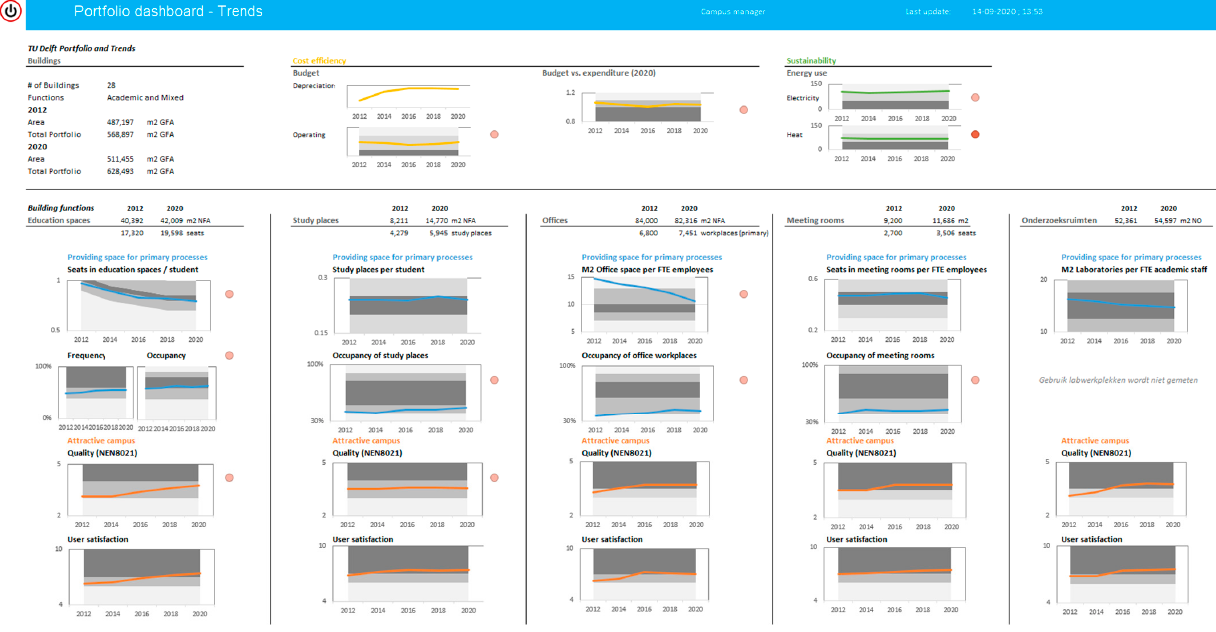
Figure A3. Trends dashboard TU Delft (workshop 2).